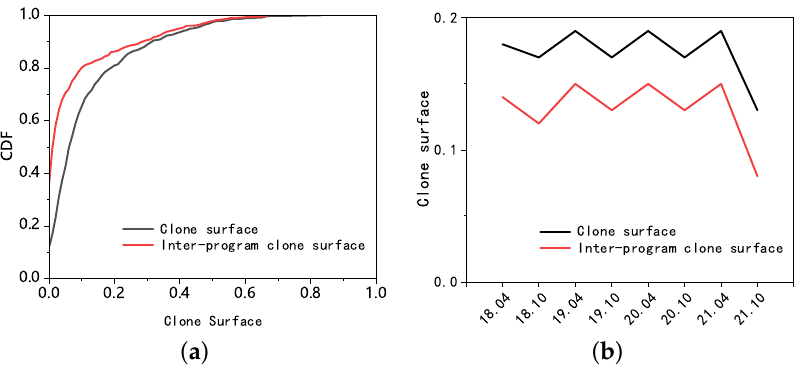
Figure 4. Clone surface. ( a ) CDF of the clone surface for programs in Ubuntu 18.04. ( b ) The clone surfaces for eight Ubuntu